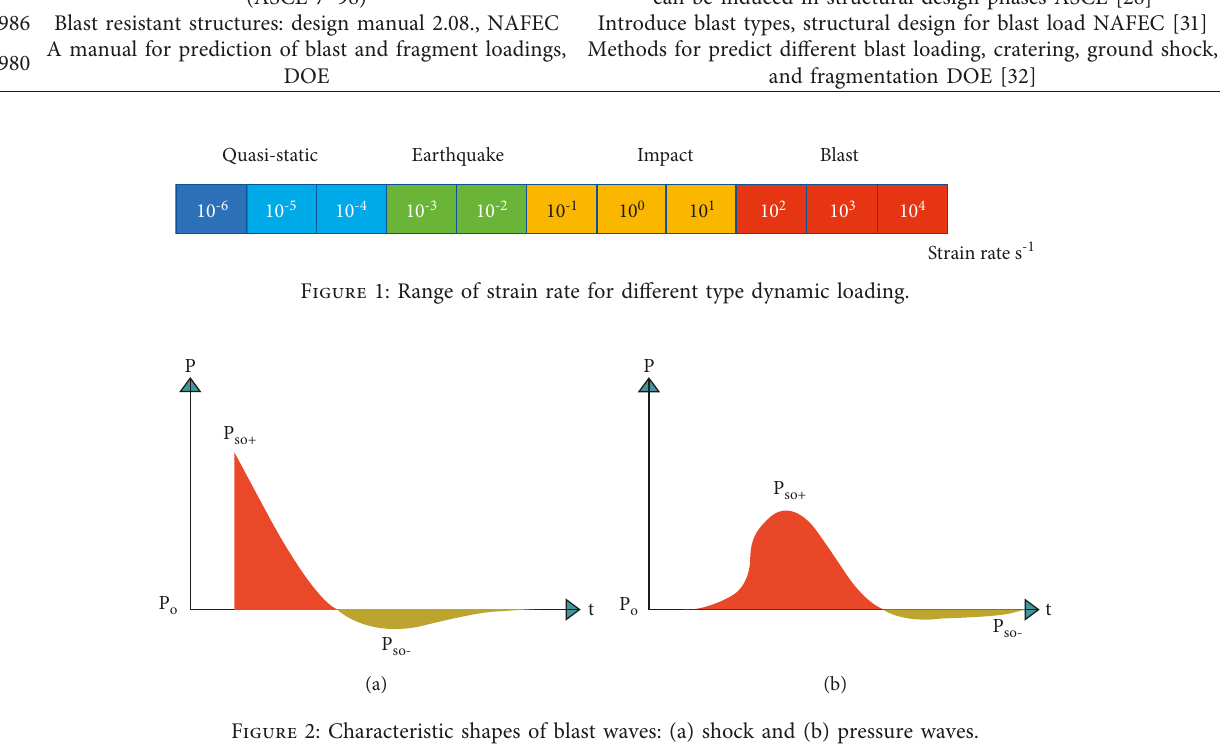
Figure 2: Characteristic shapes of blast waves: (a) shock and (b) pressure waves.